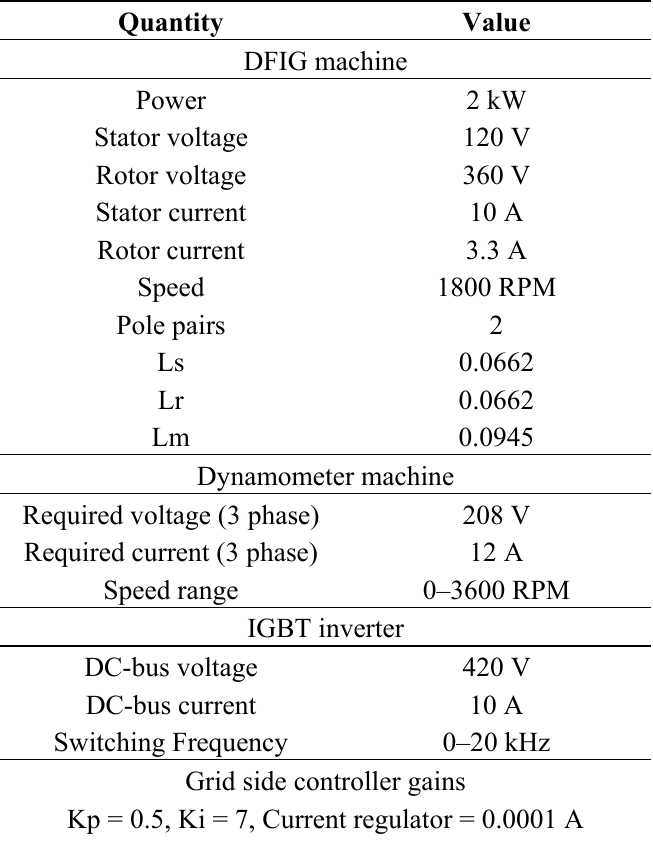
Table A1. System